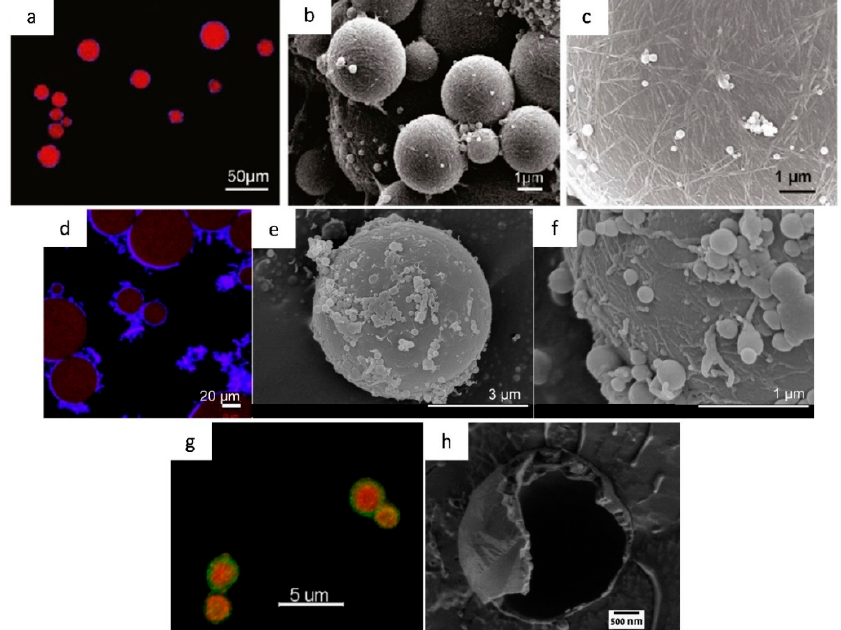
Figure 4. ( a ) Confocal laser scanning micrograph of hexadecane droplets stabilized by bacterial cellulose nanocrystals (BCN) with double staining (oil stained with BODIPY564/570 and BCN stained with calcofluor white). ( b , c ) Scanning electron micrographs of styrene-polymerized Pickering emulsion stabilized by BCN. ( d ) Confocal laser scanning micrograph of citrus oil droplets stabilized by regenerated cellulose with double straining (oil stained with Nile red and cellulose shell stained with calcofluor white). ( e , f ) Scanning electron micrographs of styrene-polymerized emulsion stabilized by cellulose regenerated from an 85 wt% phosphoric acid solution. ( g ) Fluorescence microscope image of double stained cellulose-coated emulsion droplets of n-hexadecane/toluene (1/1) (oil mixture stained with Nile red and cellulose shell stained with calcofluor white). ( h ) Cryo-SEM image of the fractured surface of an empty cellulose-shell of an emulsion prepared from a molecular solution of cellulose in 1-ethyl-3-methylimidazolium acetate (EMIMAc). Adapted with permission from [70] and [93]. Copyright 2011 and 2018 American Chemical Society.